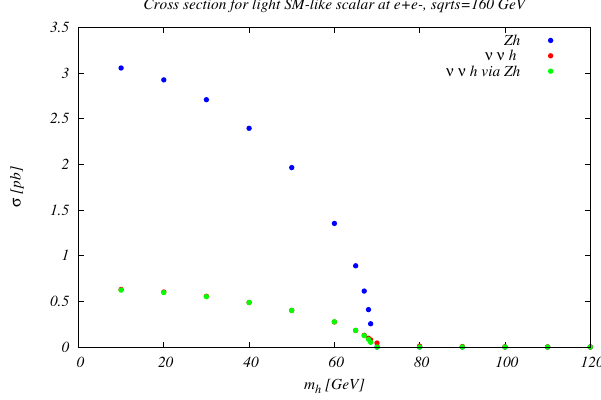
Figure 19. As Figure 9, for a com of 160 GeV. We assume onshell final